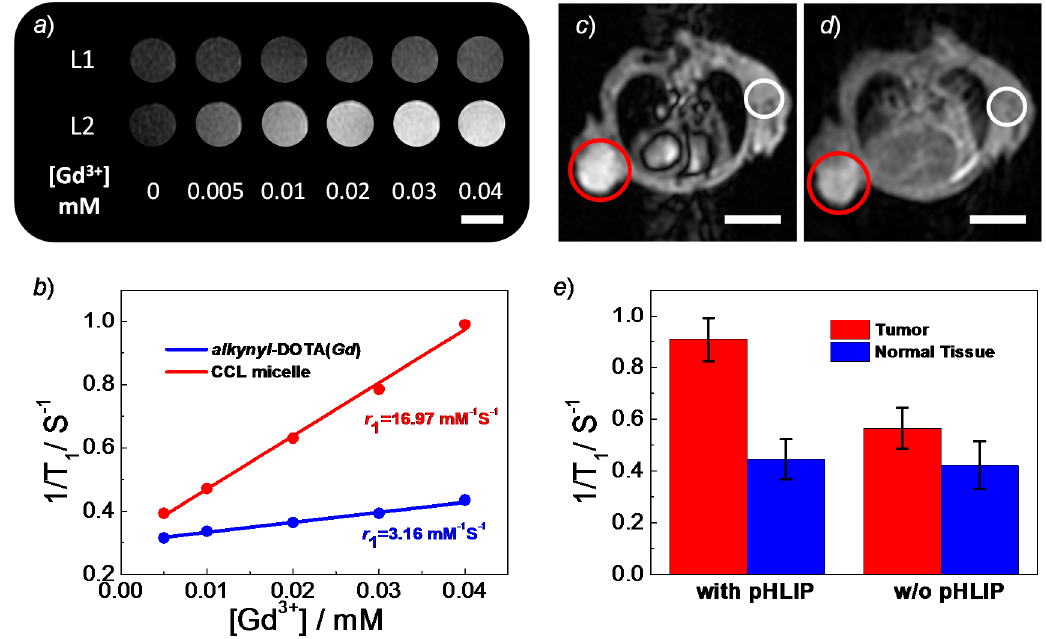
Figure 4. ( a ) T 1 -weighted spin-echo magnetic resonance (MR) imaging recorded for aqueous solutions of alkynyl-DOTA( Gd ) (L1) and DOTA( Gd )-labeled CCL micelles (L2) with varying Gd 3+ concentrations (0–0.04 mM); ( b ) water proton longitudinal relaxation rate (1/ T 1 ) of alkynyl-DOTA( Gd ) small molecule and DOTA( Gd )-functionalized CCL micelles in aqueous solution as a function of Gd 3+ concentration; ( c,d ) MR imaging of tumor-bearing BALB/c nude mice with 30 min incubation after intravenous injection of the aqueous solution of CCL micelles ( c ) with pHLIP and ( d ) without pHLIP (1.5 T, TR/TE = 800/13 ms; 25 °C). Injection was performed at a dosage of 0.1 μ mol Gd 3+ /g. The xenograft tumors of A549 cells are circled in red and the normal tissues are labeled in white; and ( e ) quantitative analysis of 1/ T 1 as calculated from images ( c ) and ( d ). The scale bars in ( a ), ( c ), and ( d ) are 1 cm.